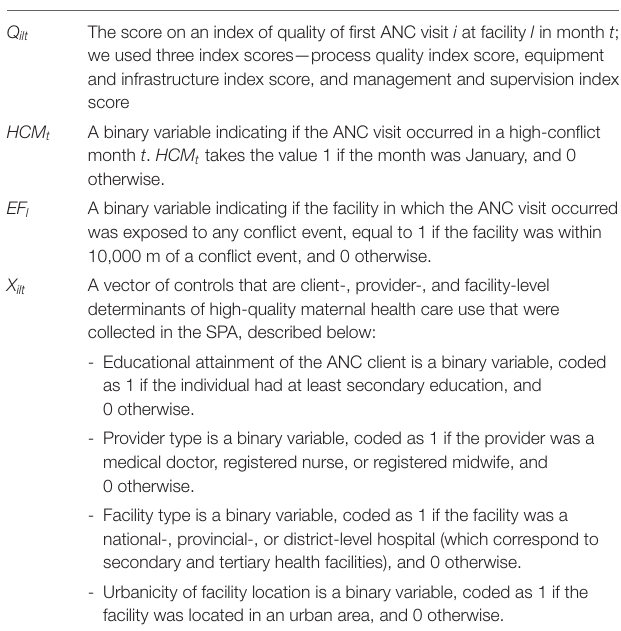
TABLE 1 | Temporal distribution of conflict events. TABLE 2 | Model